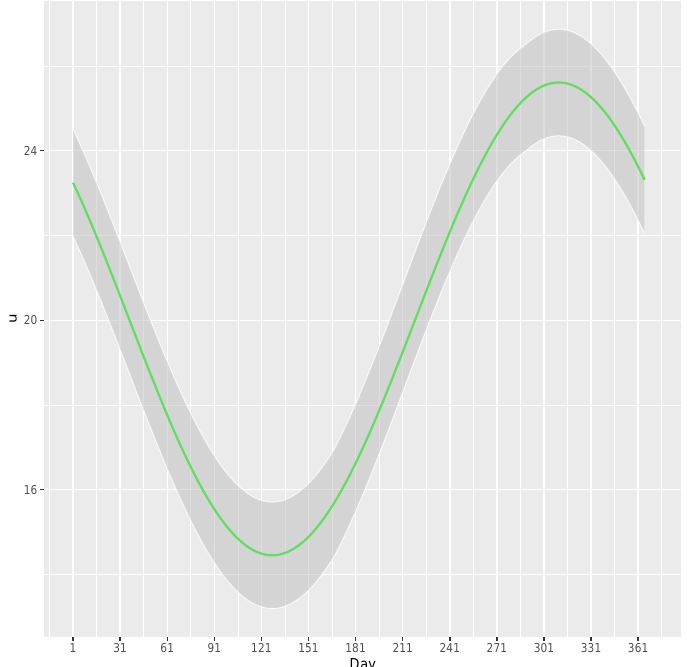
Figure 18. Parameter u varying over time for the data of Patuxent river flow. The green line is the estimate of the parameter u . The shaded area is the 95% confidence interval of the estimates.